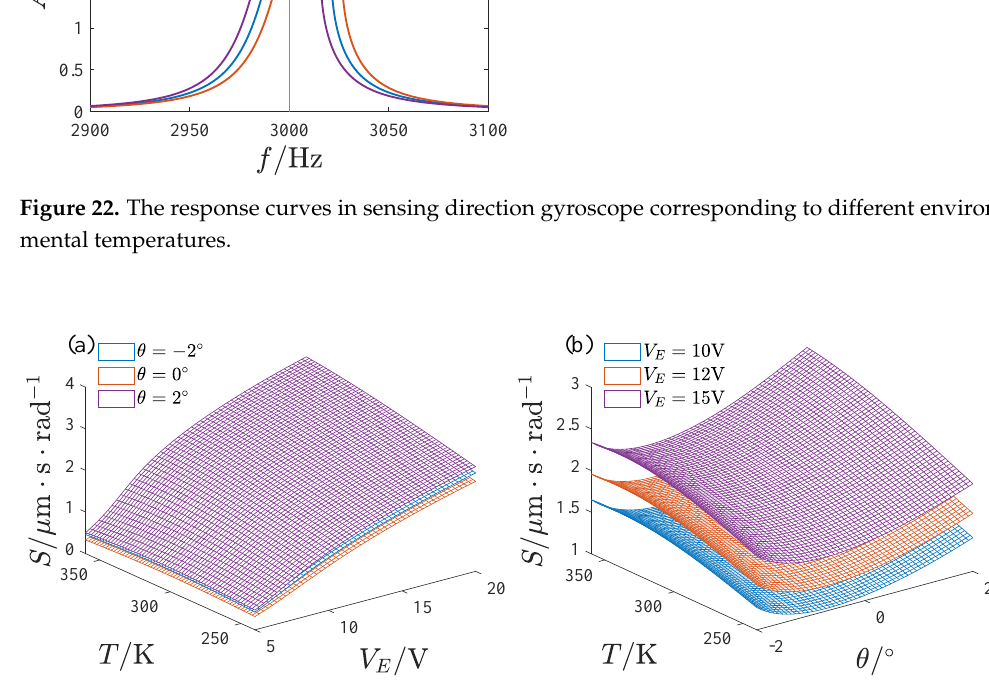
Figure 23. The variation in mechanical sensitivity with environmental temperature, ( a ) The effect of the voltage, ( b ) The effect of the inclination angle.